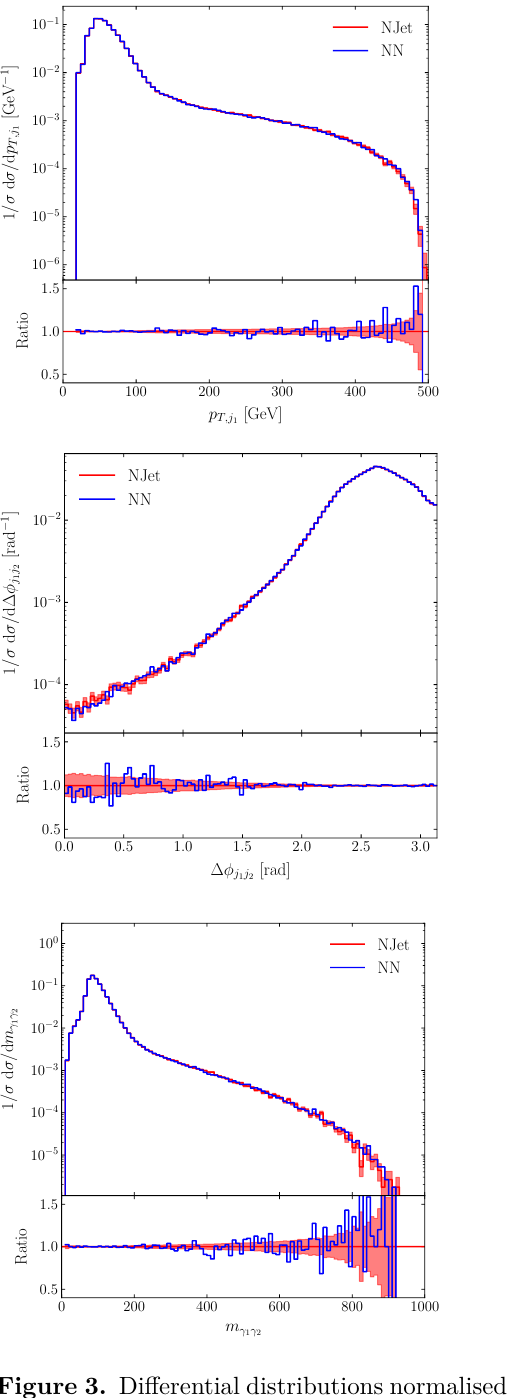
and ∆ η γ are the mass and 1 ,γ 2 1 ,γ 2